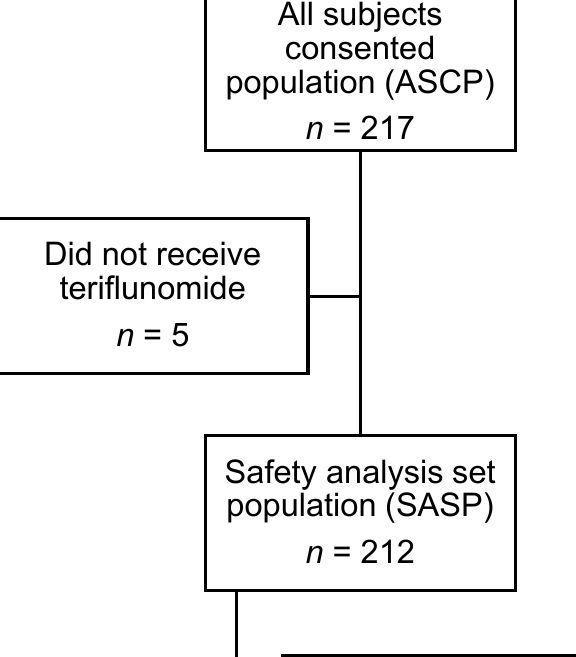
Table 1. Baseline characteristics of the Teri-REAL patient cohort (ASCP) † .